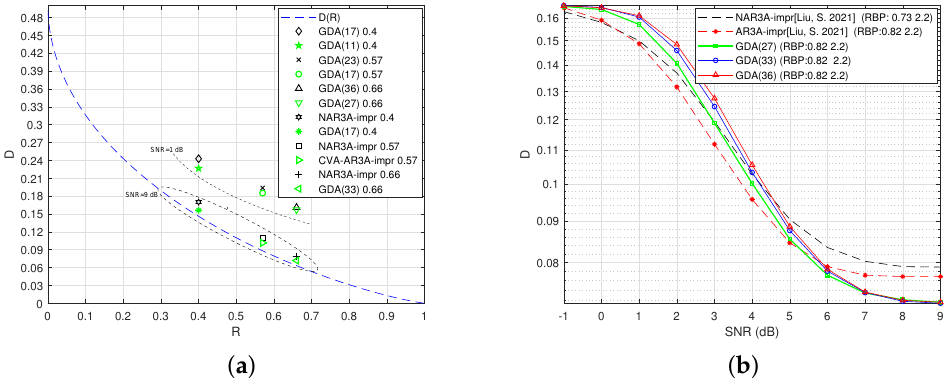
Figure 9. ( a ) Distortion rate performance [11]. ( b ) The GDA codes generated by different degrees have different D (code rate: 0.66)